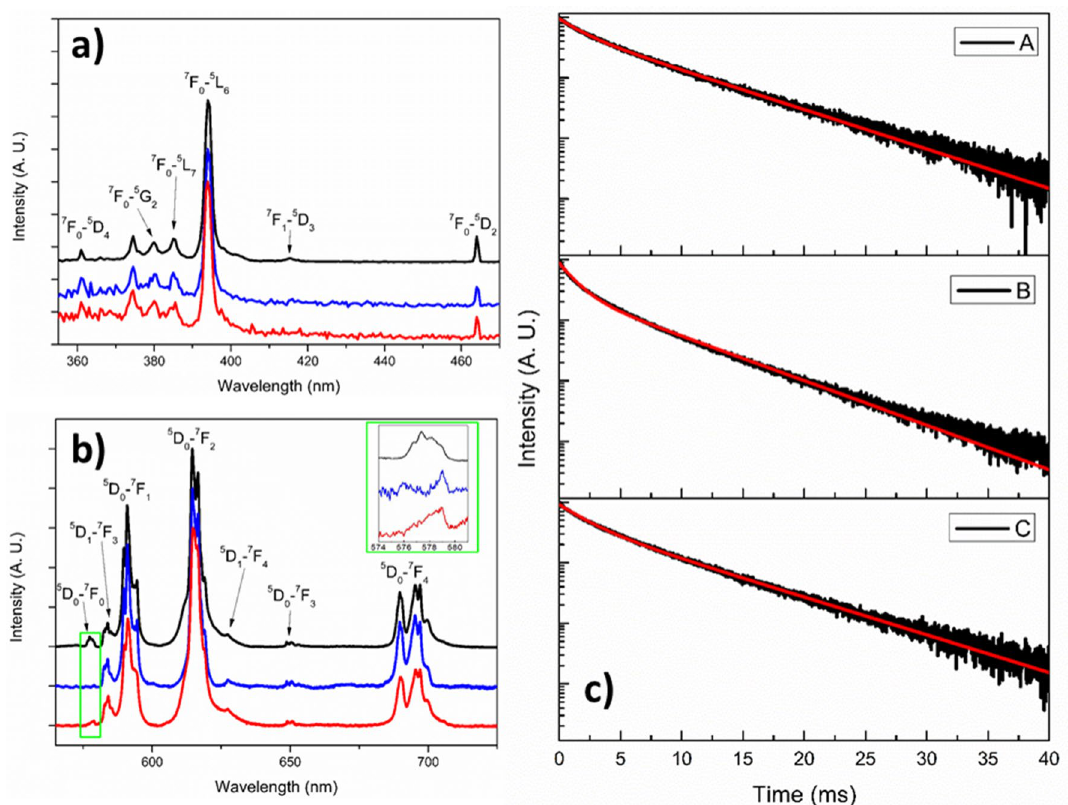
Figure 6. ( a ) Luminescence excitation spectra (λ em = 614 nm) and ( b ) emission spectra (λ exc = 532 nm) for the TiO 2 /NaYF 4 : 10% Eu (4-DS sample) nanocomposites: as-prepared (black line); after one photocatalytic cycle in the presence of methylene blue (blue line); after three photocatalytic cycles in the presence of methylene blue (red line). Emission decay curves of the band at 613 nm ( c ) for the TiO 2 /β-NaYF 4 : 10% Eu 3+ nanocomposites: as prepared sample ( A ); after one photocatalytic cycle ( B ); after three photocatalytic cycles ( C ), in the presence of methylene blue. The corresponding fits, using Eq. 2, are indicated by red